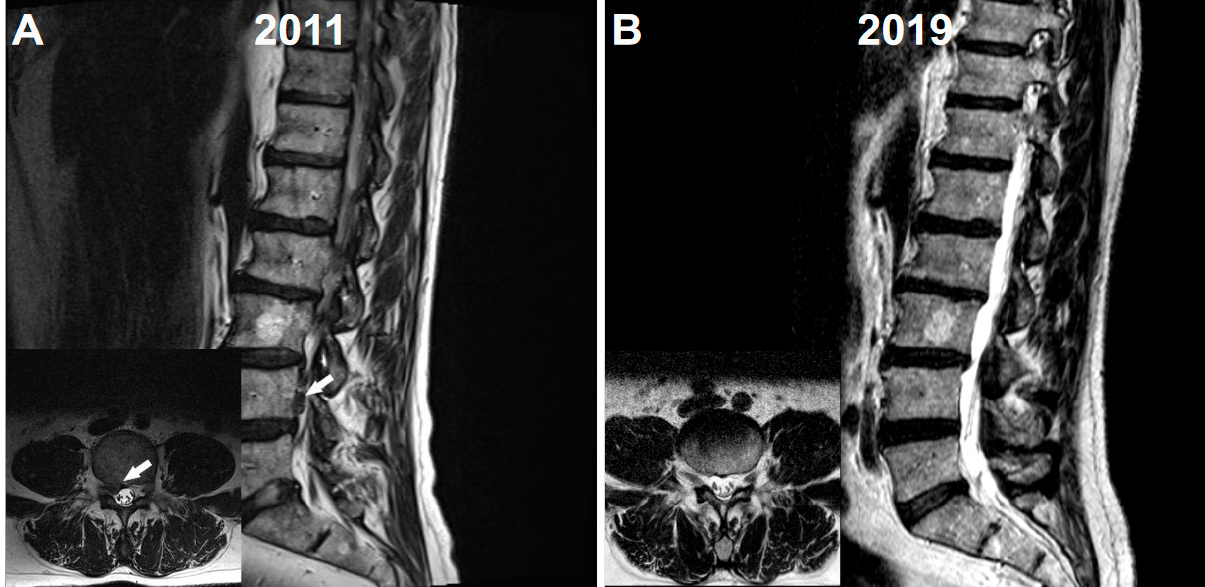
Figure 1. ( A ) T2 weighted MRI imaging from 2011 shows a herniation of the L4-5 disc. A cranially migrated sequestered disc fragment is marked by an arrow. The insert shows corresponding transversal MRI imaging. The herniation compresses the right L4 root (marked by an arrow). ( B ) Corresponding T2 weighted MRI sagittal and transversal (insert) images from 2019. No herniation of the L4-5 disc can be observed anymore. The right L4 root is not affected (see insert).